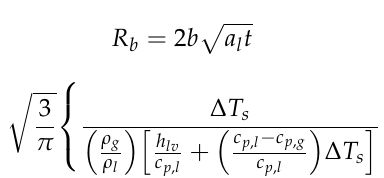
here, 𝑅 𝑏 denotes the radius of bubble (m). 𝜌 𝑙 and 𝜌 𝑔 denote the density of liquid and vapor respectively (kg/m 3 ). A is a linearization constant. 𝑇 0 is the initial temperature at the bubble boundary and 𝑇 𝑏 is the saturation temperature of the liquid (K). 𝑃 𝑔 and 𝑃 ∞ denote the vapor pressure inside bubble and the ambient pressure. During the diffusion controlled stage, the analytical solution of bubble growth in an infinite mono-component liquid can be expressed as [47]: